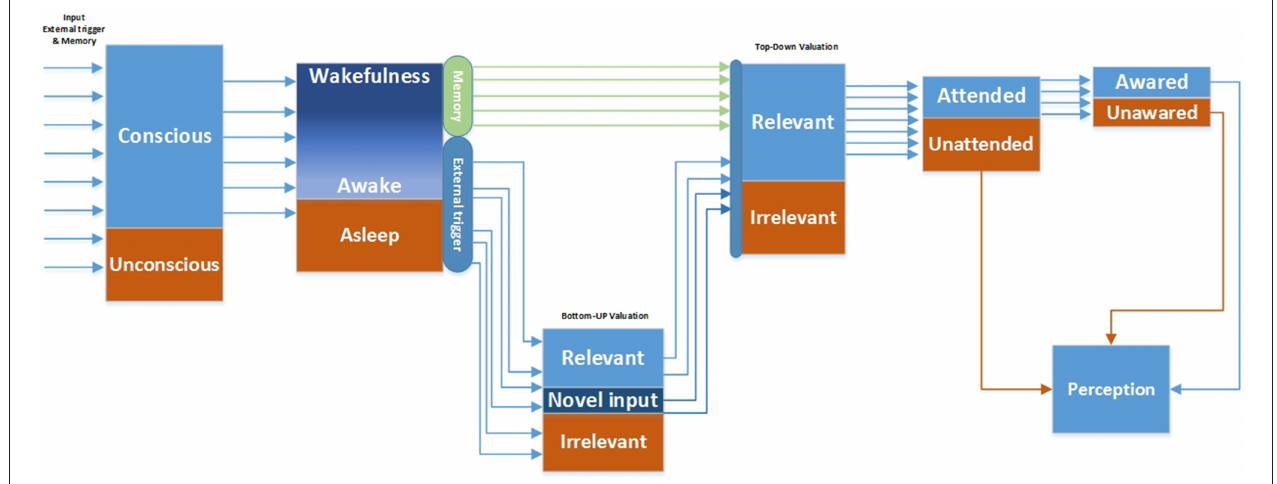
FIGURE 5 | Conscious perception process